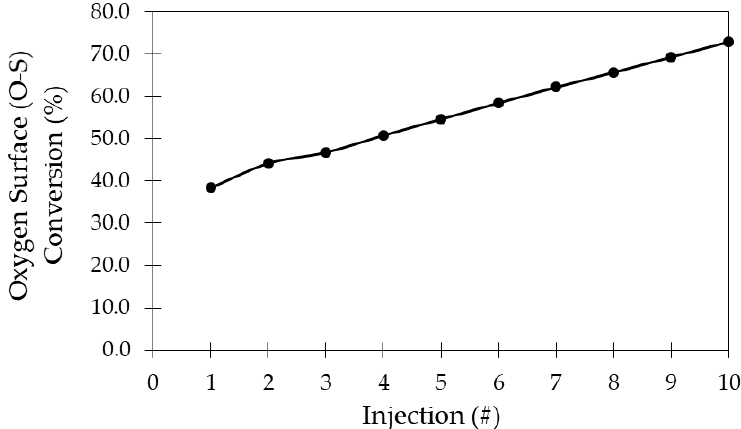
Figure A1. O–S Surface Oxygen Cumulative Conversion with the Propane Consecutive Injections for 7.5 wt. % V/ZrO 2 - γAl 2 O 3 catalyst at 550 °C in the CREC Riser Simulator.